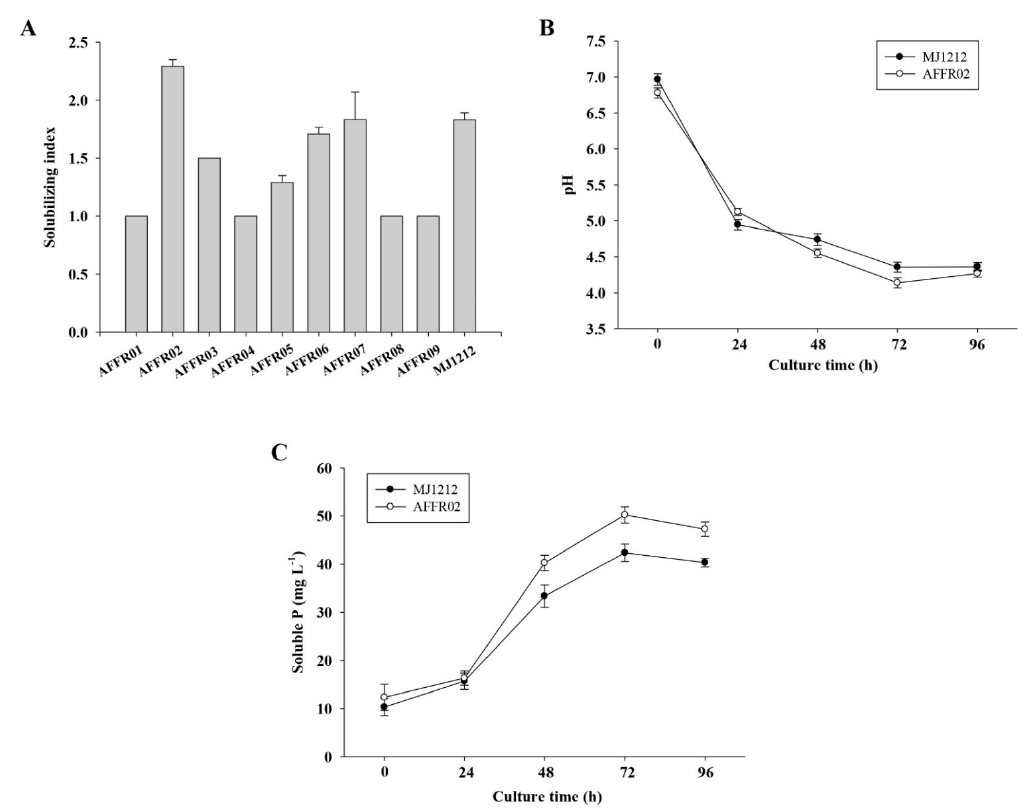
Figure 1. ( A ) Phosphate solubilization ability of isolated bacteria, ( B ) pH value of liquid National Botanical Research Institute’s phosphate (NBRIP) medium, and ( C ) the rate of the halo formation of isolate AFFR02 and MJ1212 in the NBRIP medium. The values given are the mean of three replicates, and error bars indicate standard deviation.